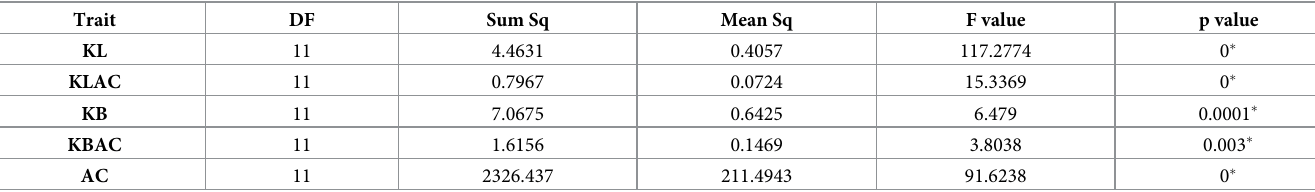
Table 3. ANOVA of variance for five cooking quality